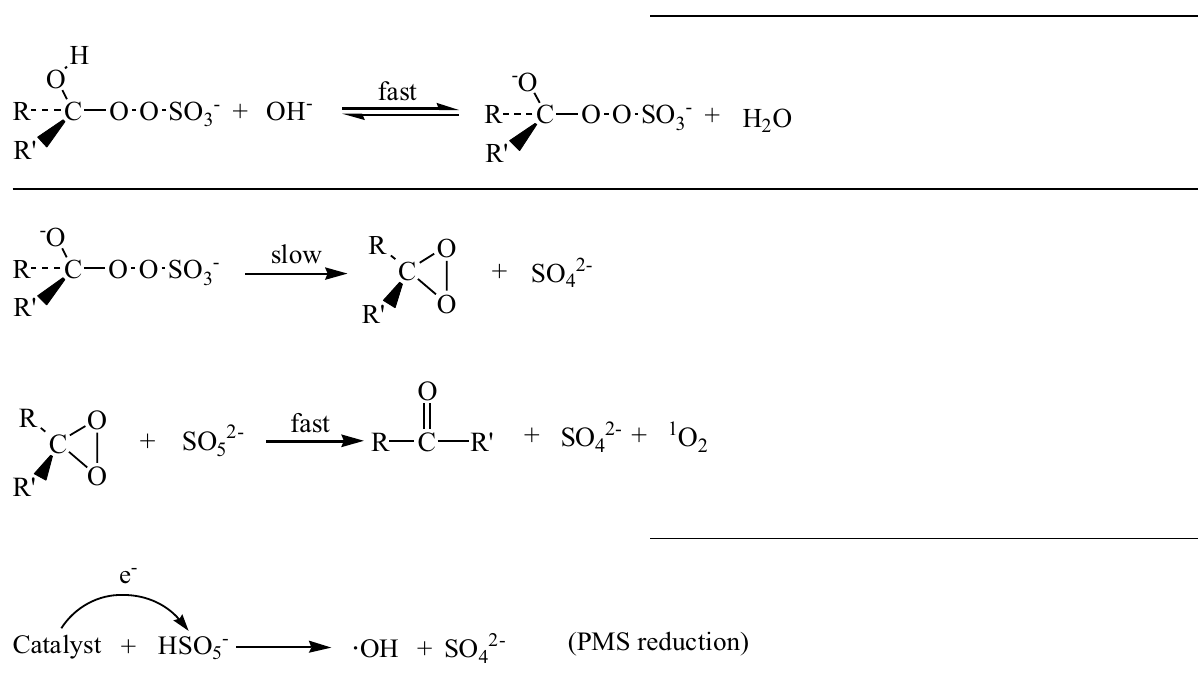
s spectra, c N 1 s spectra, and d O 1 s